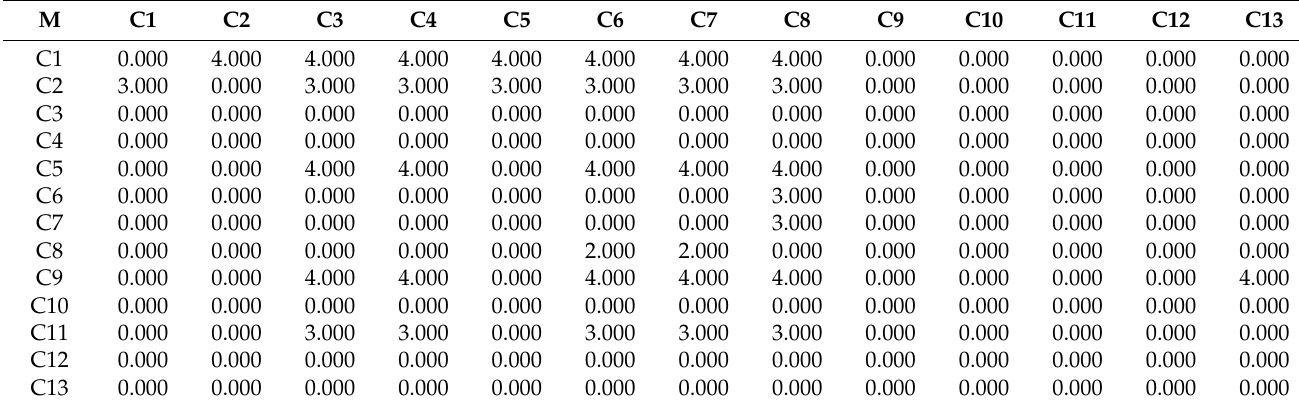
Table 4. The matrix of direct relations for decision factors M (DEMATEL method).